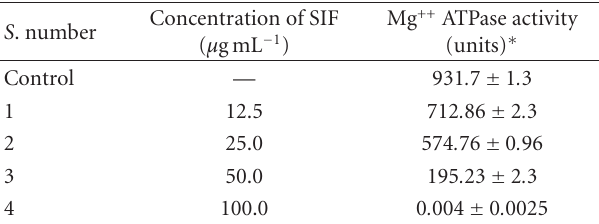
Table 1: E ff ect of SIF on Mg ++ ATPase